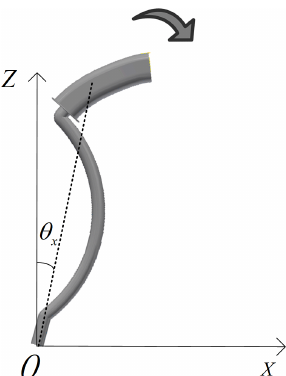
Figure 6. The experimental process.